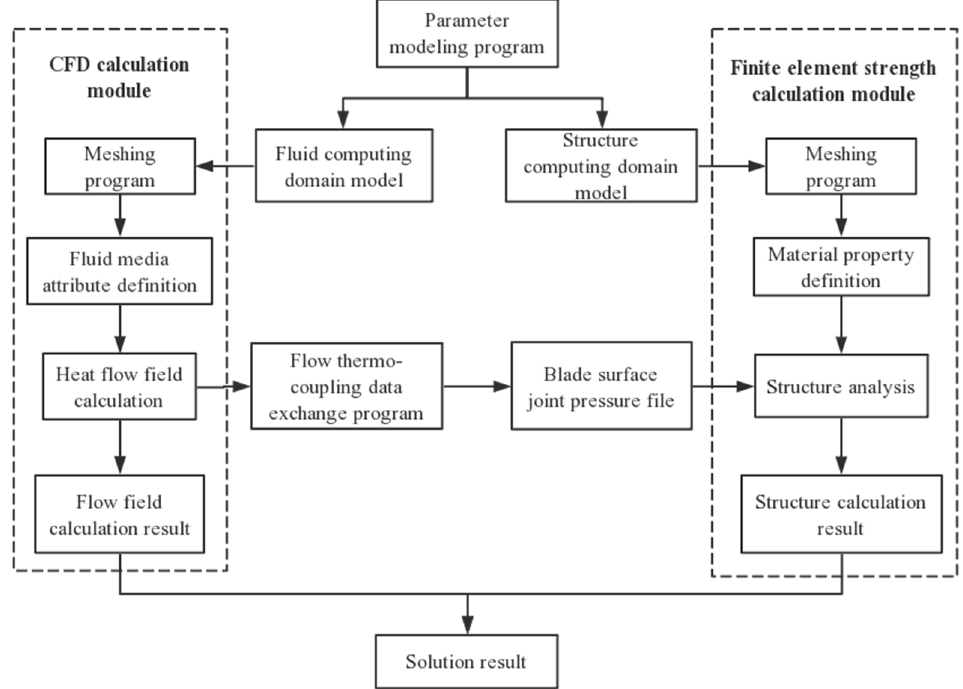
Figure 1. Flow chart of flow thermo-coupling solution strategy.